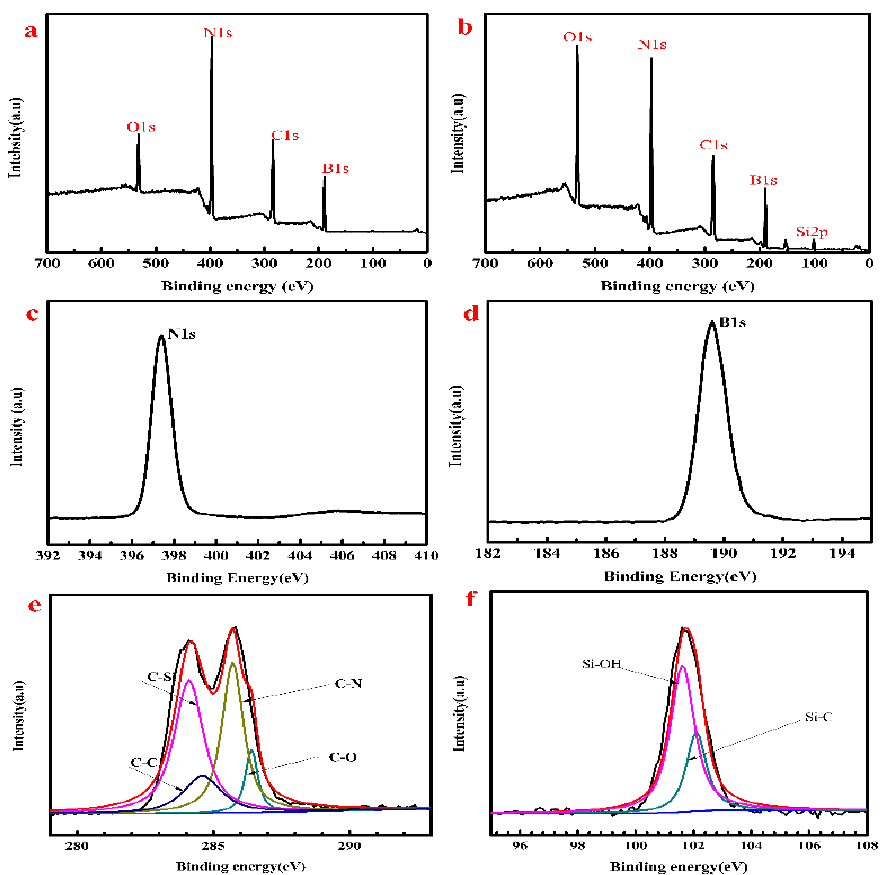
Figure 6. ( a ) and ( b ) are survey spectra of XPS results of BNNS and 560/BNNS, high resolution spectra Figure 6. ( a , b ) are survey spectra of XPS results of BNNS and 560 / BNNS, high resolution spectra ( c , d ) ( c,d ) of BNNS, high resolution spectra ( e,f ) of 560/BNNS. of BNNS, high resolution spectra ( e , f ) of 560 /